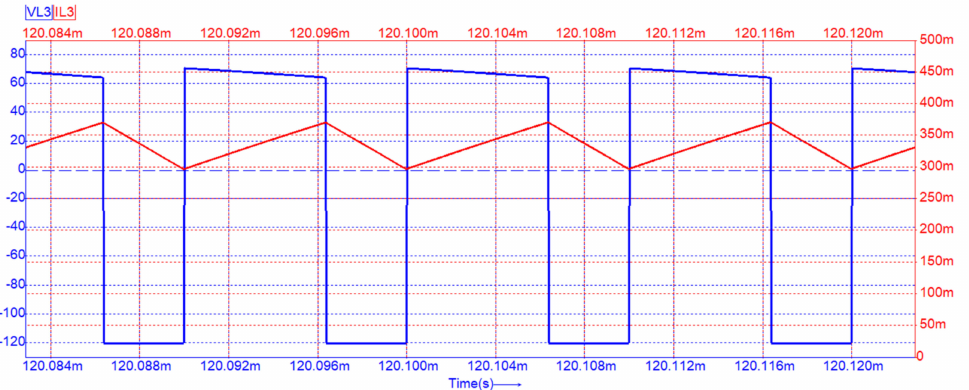
Figure 11. Voltage (blue) and current (red) of the secondary winding L 2 .